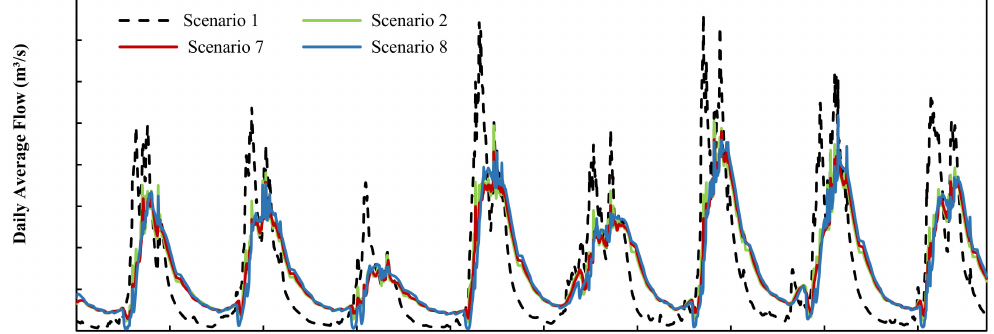
Figure 9. The daily simulation results of runoff (2009–2016) at Ertan station (Scenarios 1–2 &